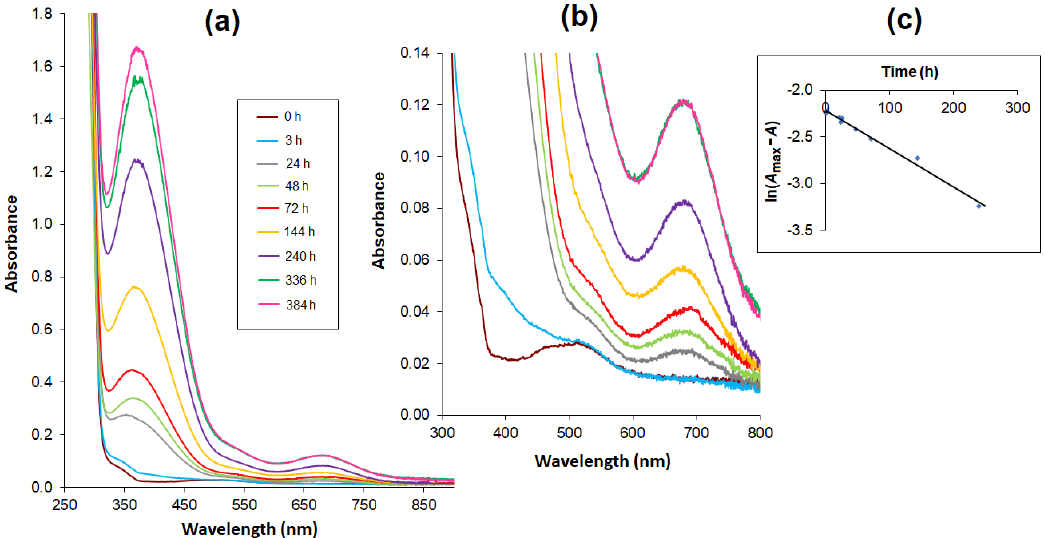
Figure 4. Absorption spectra of complexes in the Co(II) – AlaSal system ( C AlaSal = 2 × 10– 3 mol L −1 , at at ligand-to-metal molar ratio 2:1) in 5 mM Tris-HCl / NaCl bu ff er at pH 7.2, recorded at consecutive ligand-to-metal molar ratio 2:1) in 5 mM Tris-HCl/NaCl buffer at pH 7.2, recorded at consecutive time time intervals within the wavelength range ( a ) 250–900 nm ( b ) 300–800 nm – extended part of spectra. intervals within the wavelength range (a ) 250–900 nm ( b ) 300–800 nm – extended part of spectra. ( c ) ( c ) Time relationship of logarithmic values: ln( A max − A ) at 683 Time relationship of logarithmic values: ln( A max − A ) at 683 nm.